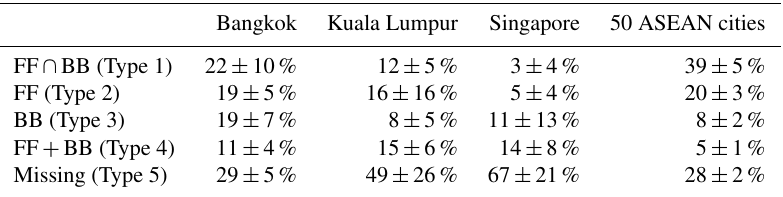
Table 2. The contribution of fire aerosols (BB), non-fire aerosols (FF), or coexisting aerosols to LVDs (based on the logic chart in Fig. 2) in Bangkok, Kuala Lumpur, Singapore, and among 50 Association of Southeast Asian Nations (ASEAN) cities during 2002–2008. Bangkok Kuala